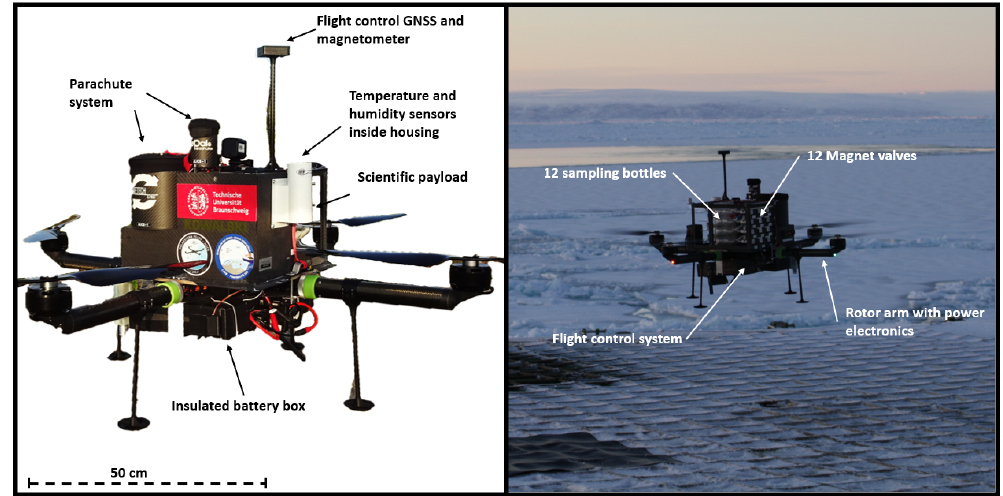
Figure 2. Quadrocopter ALICE with its components and sensors. The white housing containing the meteorological sensors is visible in the left